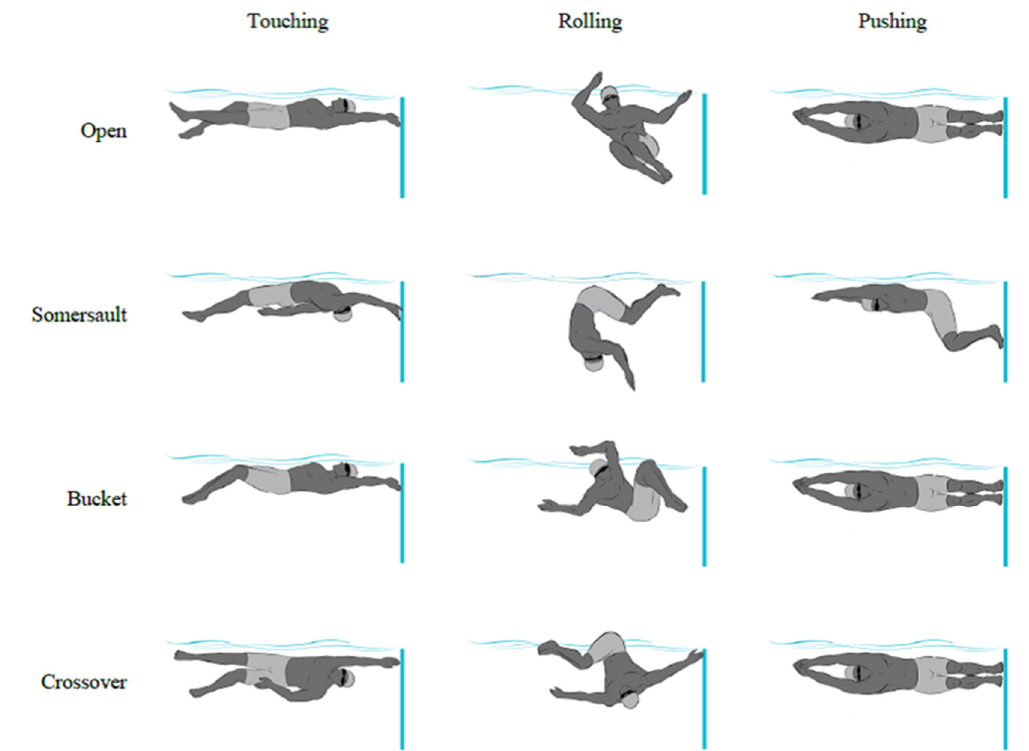
Figure 1. Representation of a swimmer’s body orientations during the rotation and push-off phases for the four studied backstroke-to-breaststroke turning techniques.